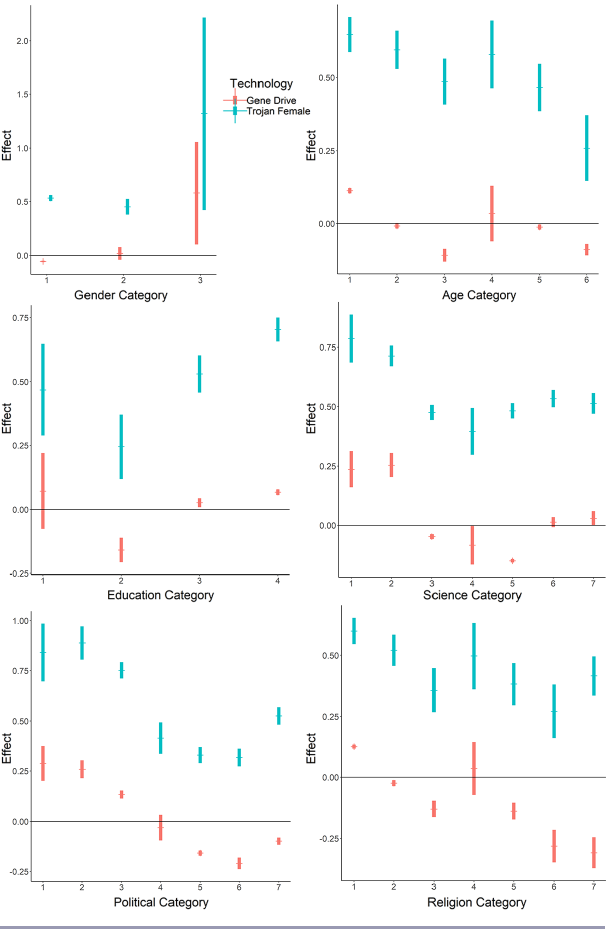
Fig. 1 . Group-wise preference for Gene Drive and Trojan Female over New Toxin. Group average with 95% confidence interval. GD shown in red, TF in